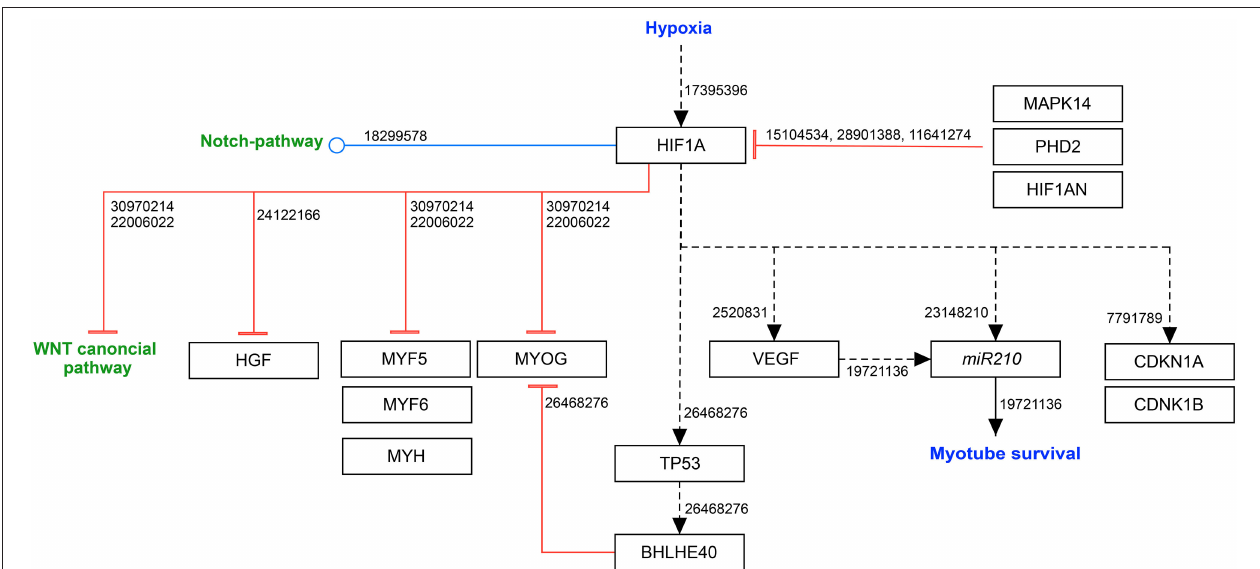
FIGURE 3 | HIF1A modulates myogenic differentiation in hypoxia. Black arrow: activation of the signaling pathway/protein/molecule. Blunt red arrow: inhibition of the signaling pathway/protein/molecule. Round blue arrow: Interaction between two pathways. Numbers: PubMed-IDs.